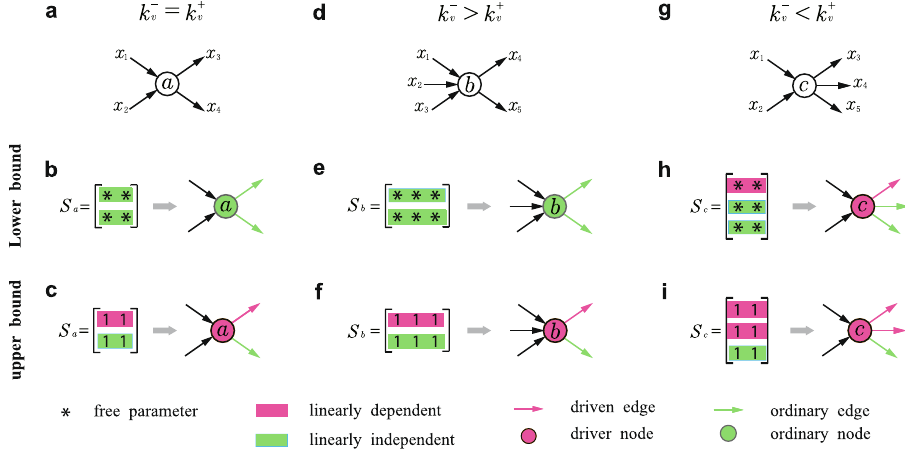
Figure 2. Classification of edges and nodes based on local information. ( a ) Node a with two incoming and outgoing edges. ( b ) Structural switching matrix S a of node a and the category of node a and its outgoing edges. S a is row-full rank, so the two outgoing edges are non-essential (ordinary) edges and a is a non-essential node. ( c ) Unweighted switching matrix S a and the category of node a and its outgoing edges. In S a , there is a linearly dependent row corresponding to a driven outgoing edge. Node a at the tail end of the driven edge is a driver node. ( d ) Node b with three incoming edges and two outgoing edges. ( e ) Structural switching matrix S b with row-full rank and the category of node b and its outgoing edges. Node b and its outgoing edges are non- essential. ( f ) Unweighted switching matrix S b and the category of node b and its outgoing edges. The row-rank of S b is unity, leading to one driven edge. Node b becomes a driver node with one driven edge. ( g ) Node c with two incoming edges and three outgoing edges. ( h ) Structural switching matrix S c with deficient row-rank and the category of node b and its outgoing edges. The row-rank of S c is 2, so there are two non-essential edges. Node c is a driver node with one driven edge. ( i ) Unweighted switching matrix S c and the category of node c and its outgoing edges. The row-rank of S c is unity, indicating one non-essential edge and two driven edges. Node c with two driven outgoing edges is thus a driver node. The structural switching matrices in ( b ), ( e , h ) correspond to the lower bound, and the unweighted switching matrices in ( c ), ( f , i ) are associated with the upper bound.